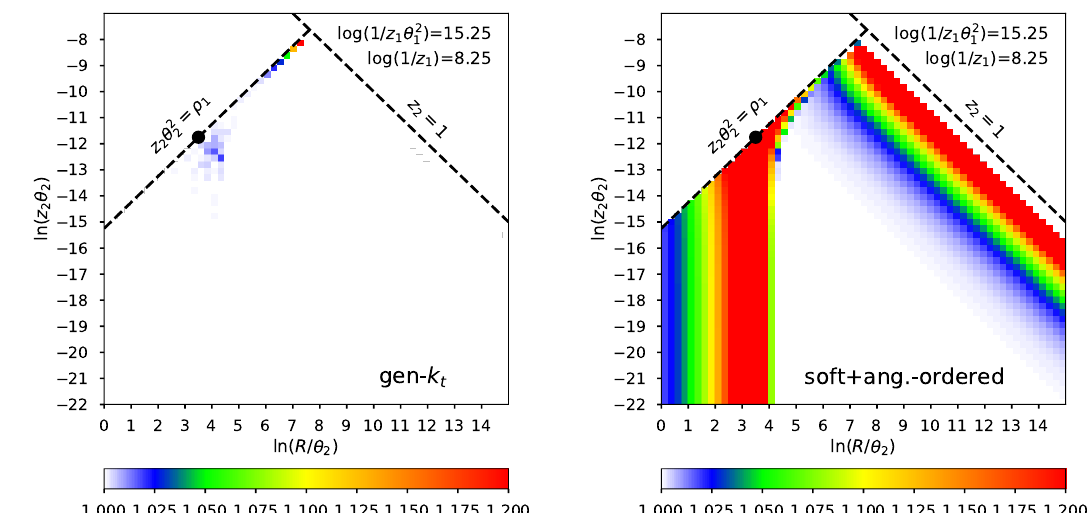
Figure 1 . Plots of the ratio of the (cid:28) 21 obtained in di(cid:11)erent limits. A (cid:12)rst emission is (cid:12)xed at the indicated point and the plots are done varying the second emission. On the left, we show the ratio (cid:28) (gen- k t ) =(cid:28) (min) and on the right the ratio (cid:28) (soft+ang.-ordered) 21 21